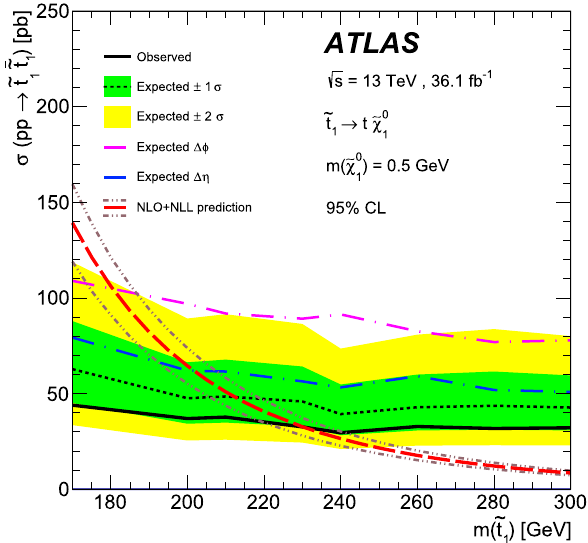
Fig. 16 Expected and observed limits at 95% CL on the top squark pair production cross-section as a function of m ˜ t assuming a 100% 1 = 0 . 5 GeV. The dashed decays with m ˜ χ 0 branching ratio for ˜ t 1 → t ˜ χ 0 1 1 line shows the expected limit with ± 1 and ± 2 standard deviation bands. The dashed line shows the theoretical cross-section with uncertainties. The solid line gives the observed limit. Also shown are the expected limits using the (cid:3)φ and (cid:3)η distributions separately